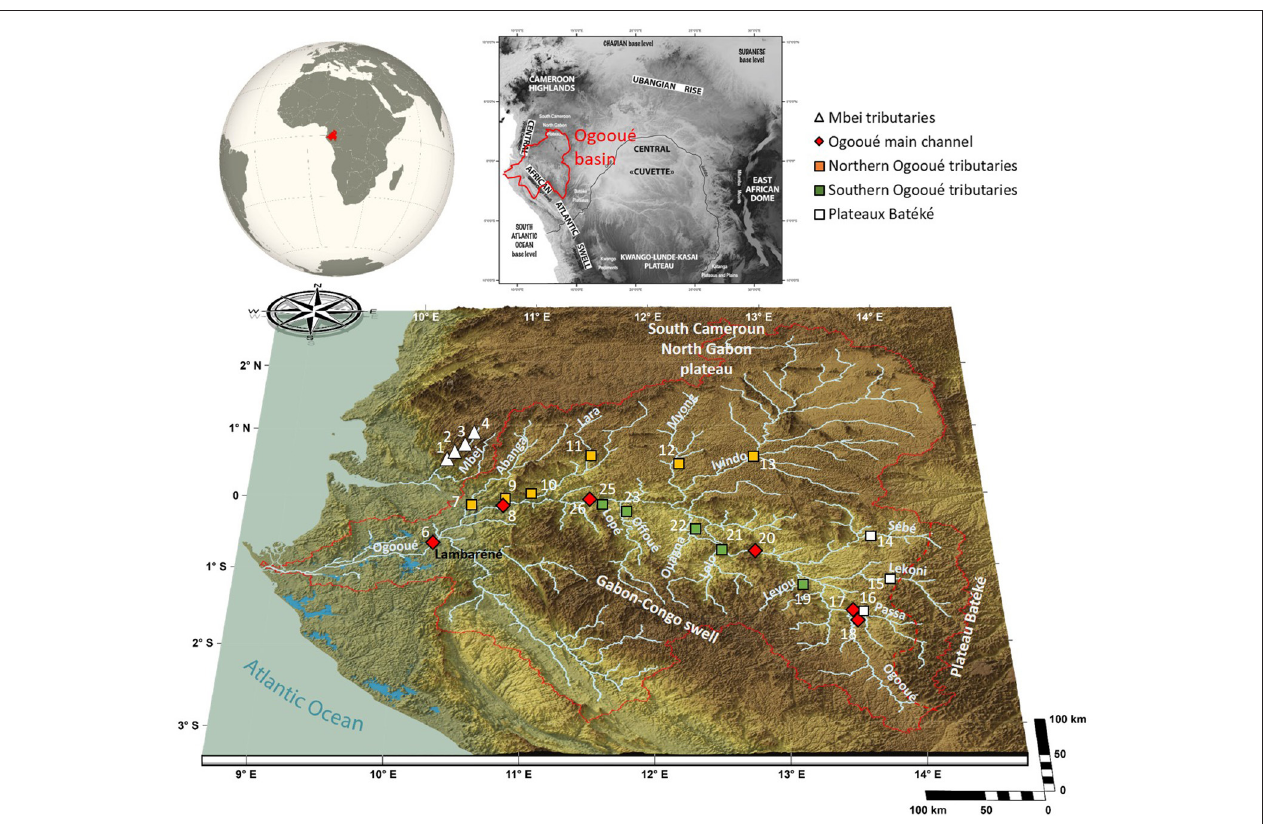
FIGURE 1 | Study area and sampling locations. The regional map of the study area is modified from Guillocheau et al. (2015).